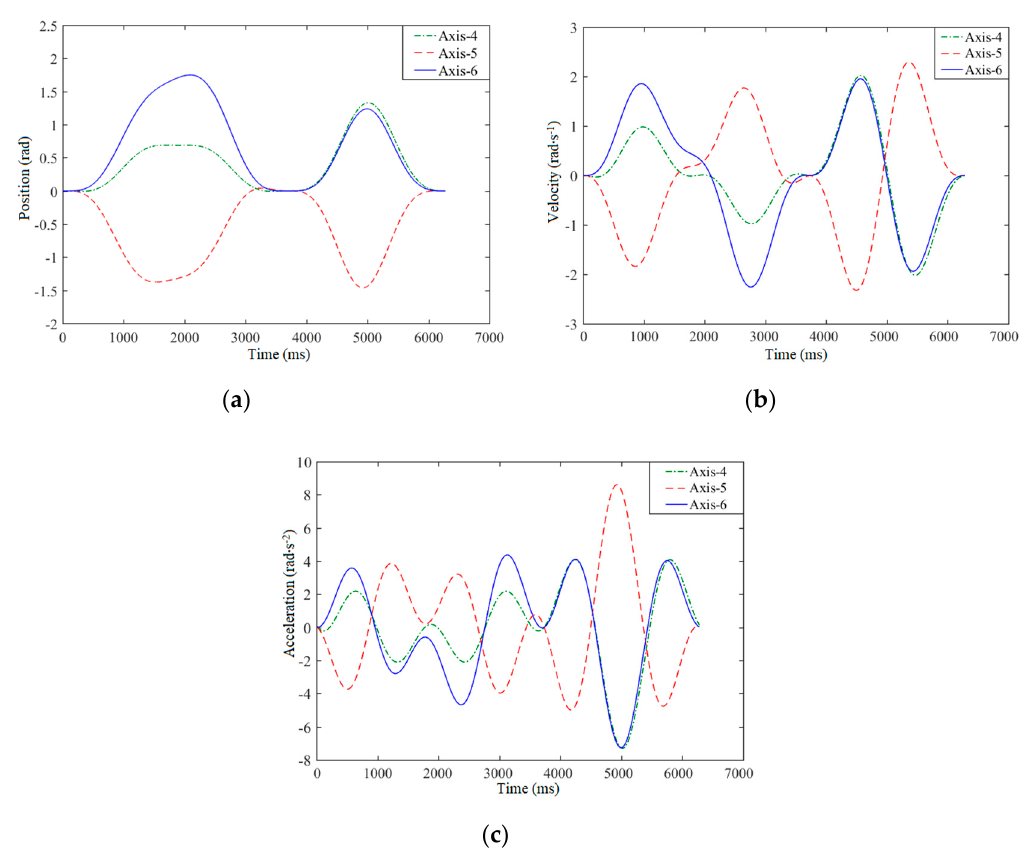
Figure 4. Excitation trajectory of test set. ( a )–( c ) are the position, velocity, and acceleration of excitation trajectory of test set, respectively .